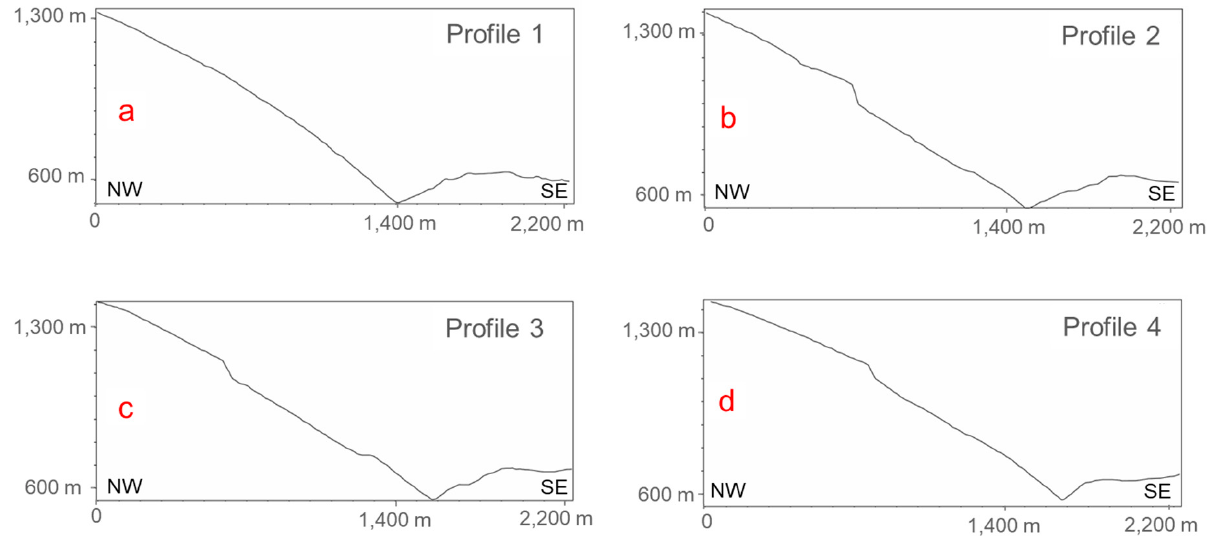
Figure 11. Slope profiles along the four cutting planes highlighted in Figure 2, ( a ) profile 1, ( b ) pro- file 2, ( c ) profile 3 and ( d ) profile 4. 2, ( c ) profile 3 and ( d ) profile